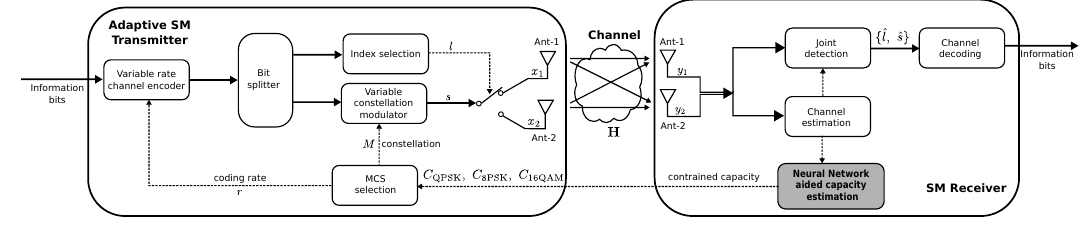
Figure 1. Block diagram of an adaptive SM system with ACM.